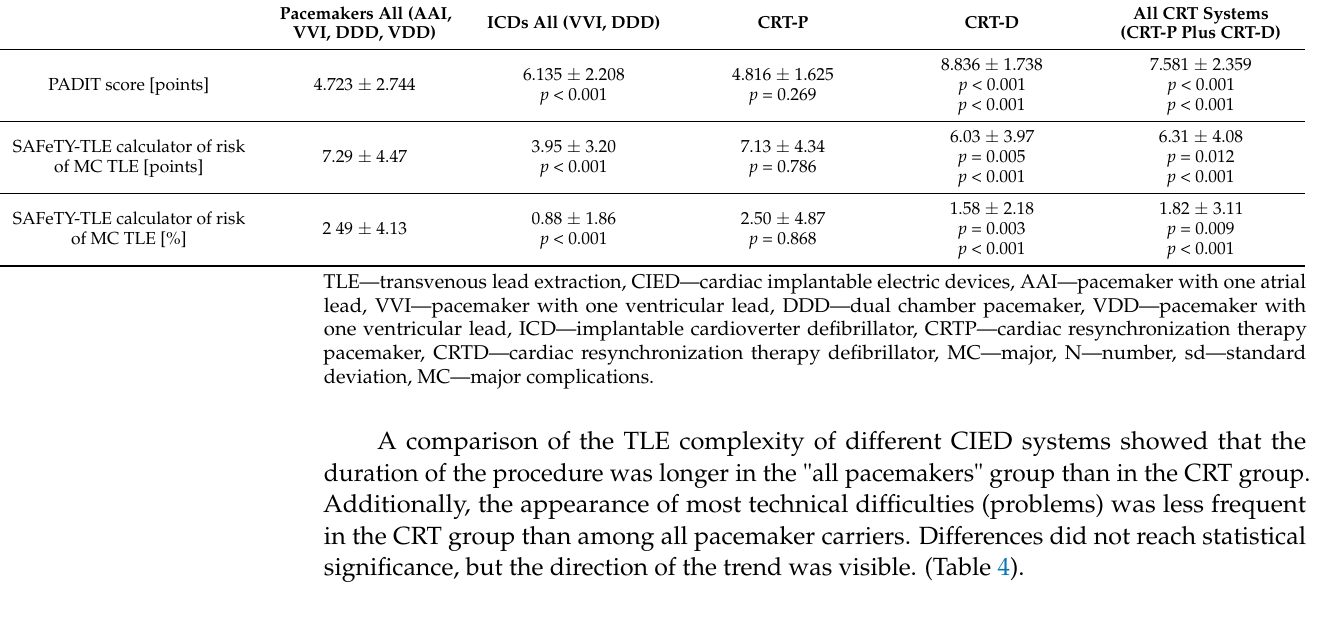
Table 4. TLE complexity in compared groups of patients with different CIED